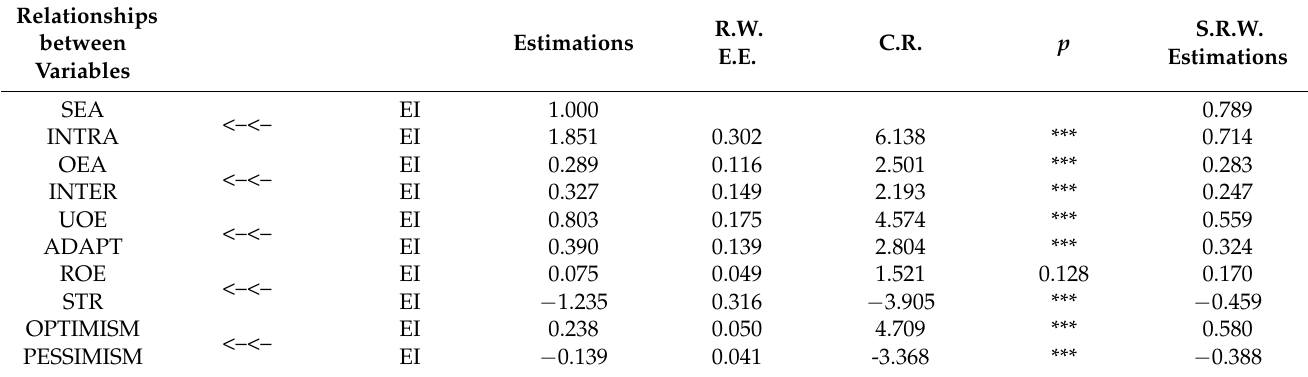
Table 5. Regression weights and standardised regression weights for